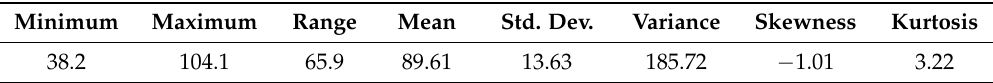
Table A1. Statistics of the air outlet relative humidity distribution [%].